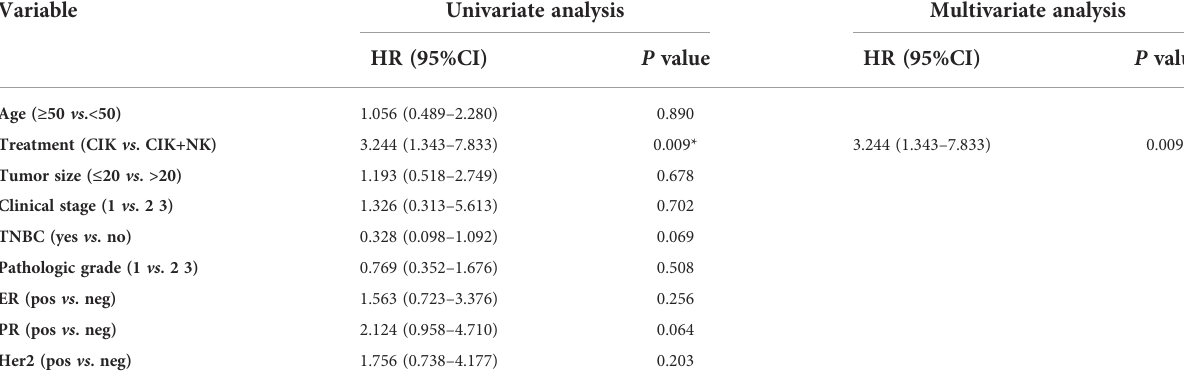
TABLE 5 Univariate and multivariate analysis of overall survival for breast patients in the CIK and CIK+NK